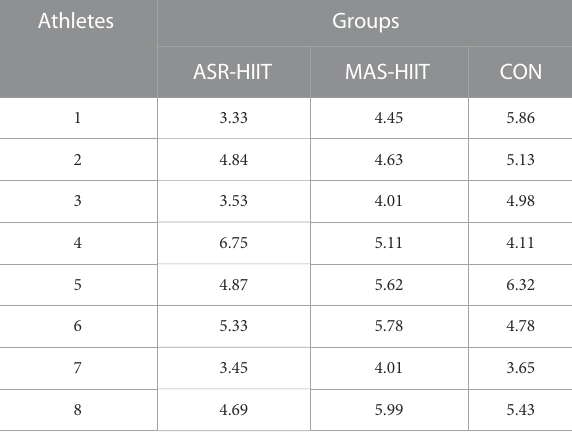
TABLE 1 Pre-training anaerobic speed reserve [ASR (km · hr − 1 )] values of the participants. Athletes Groups